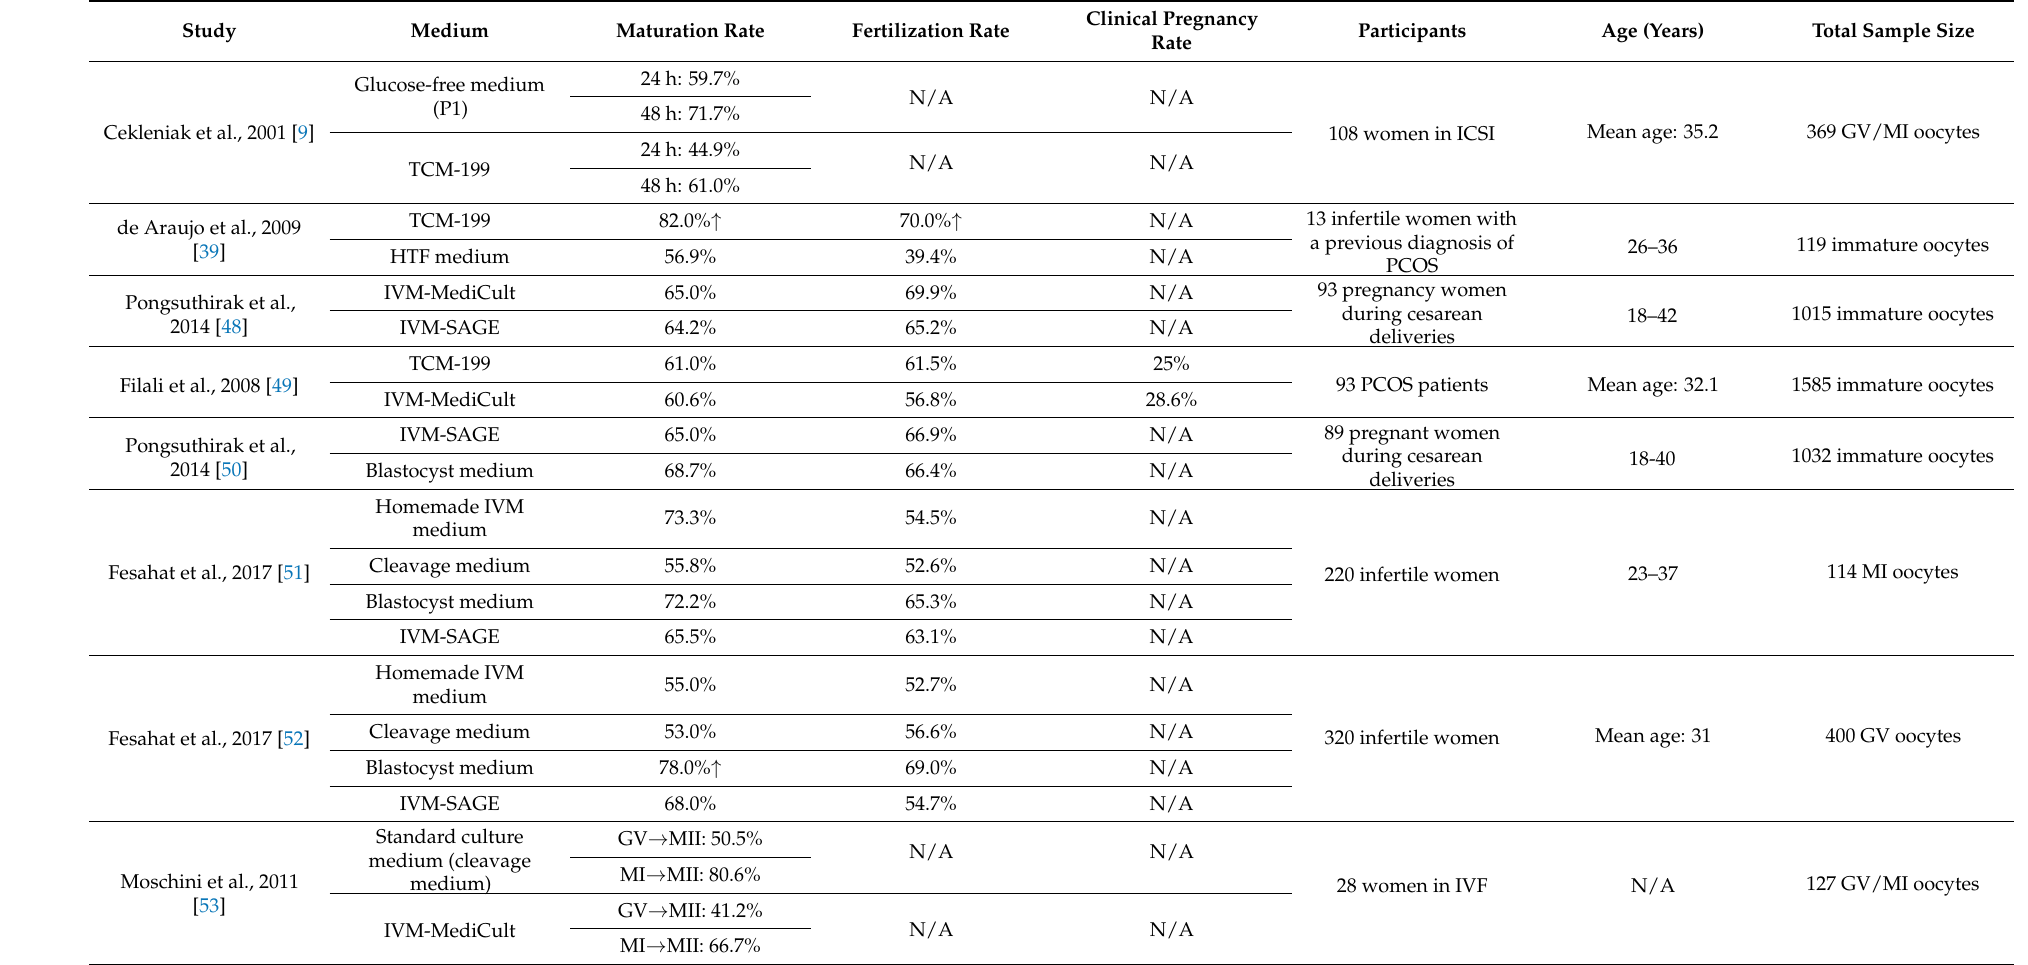
Table 2. Influence of culture media on human oocyte